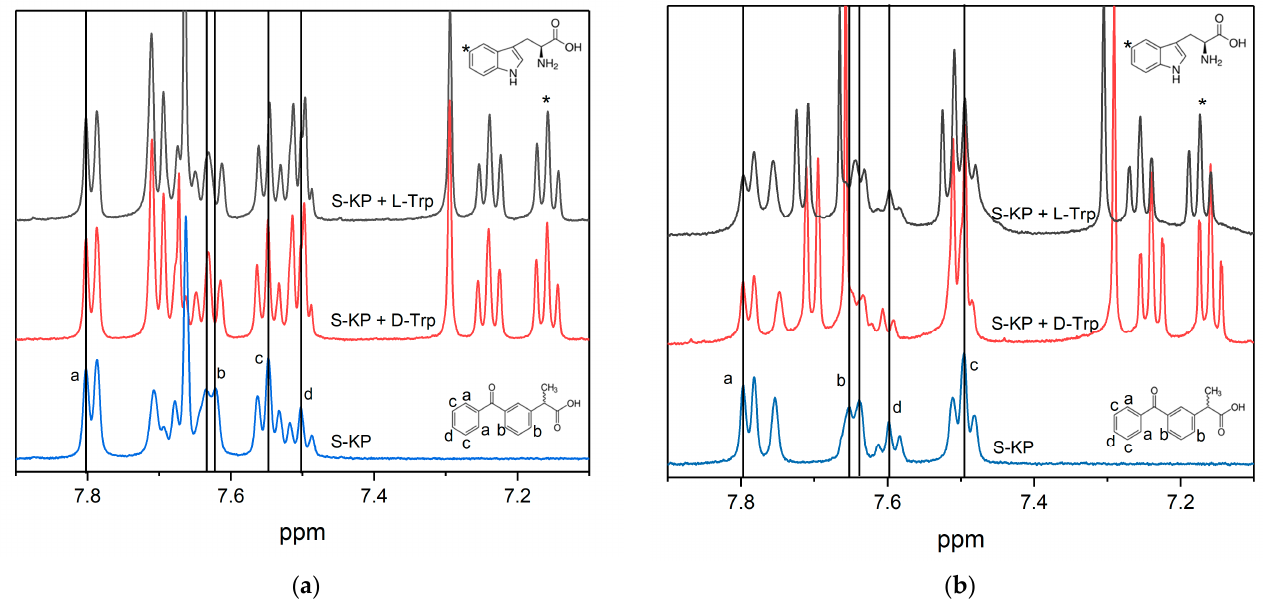
Figure 3. 1 H NMR spectra of S-KP in the absence (blue) and in the presence (black and red) of L/D-Trp in bicelles ( a ) in PBS at pH = 7.4; ( b ) at pH = 4. The most significant differences are observed for protons of KP marked with symbol (b) (Figure 3). The shift of this proton is higher in the case of deprotonated KP state (pKa value is 4.7) at pH = 7.4 than in the case of protonated KP state at pH = 4. It could mean a stronger interaction of KP with Trp in the case of a deprotonated KP